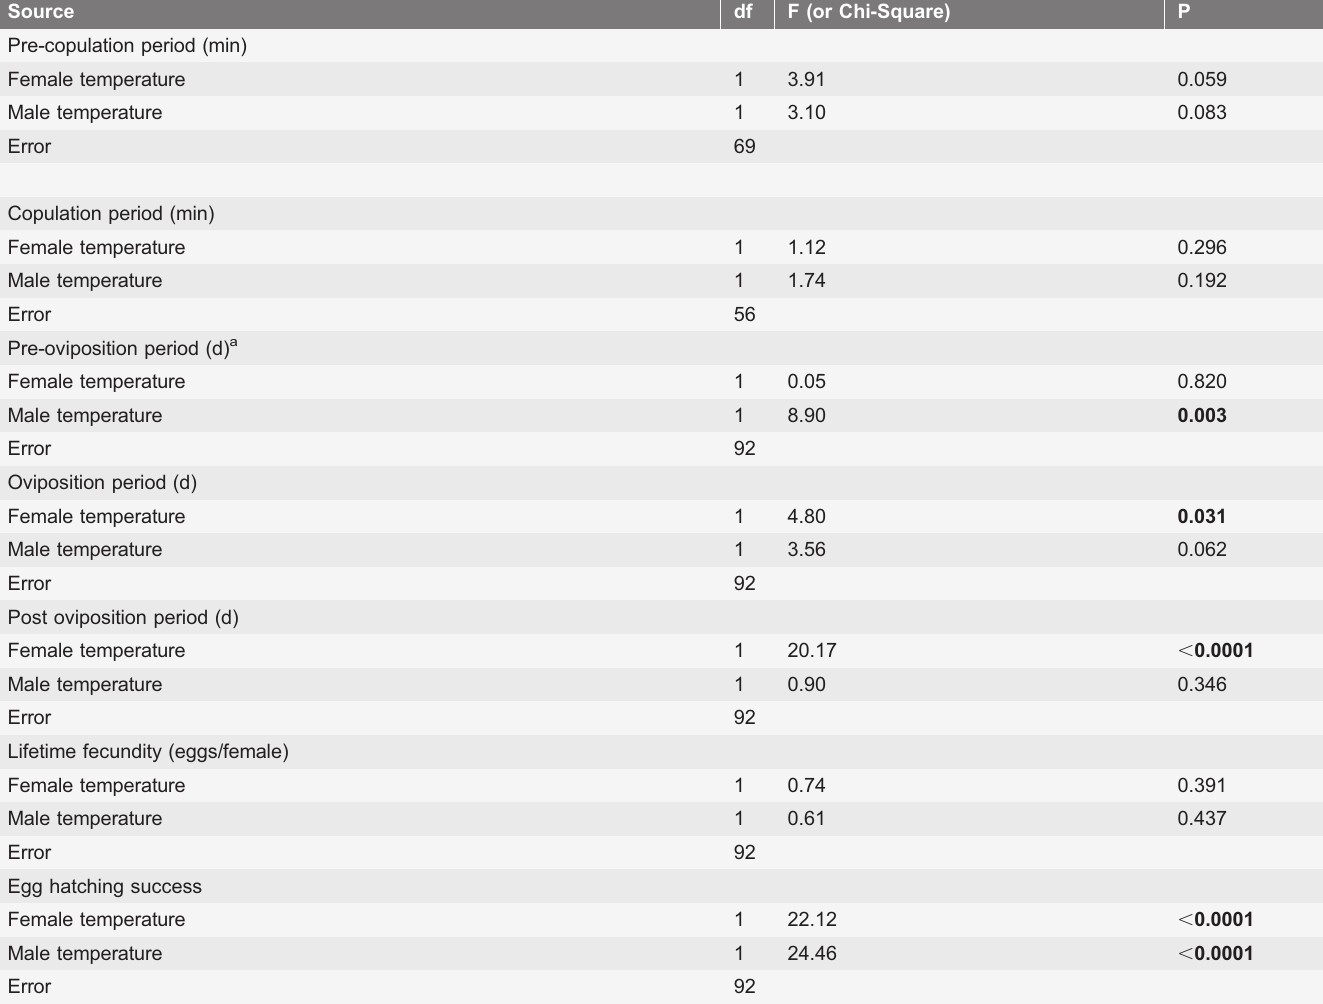
Table 1. Results of general linear models testing the effects of female and male temperature (25 ˚ C versus 38 ˚ C) on reproduction